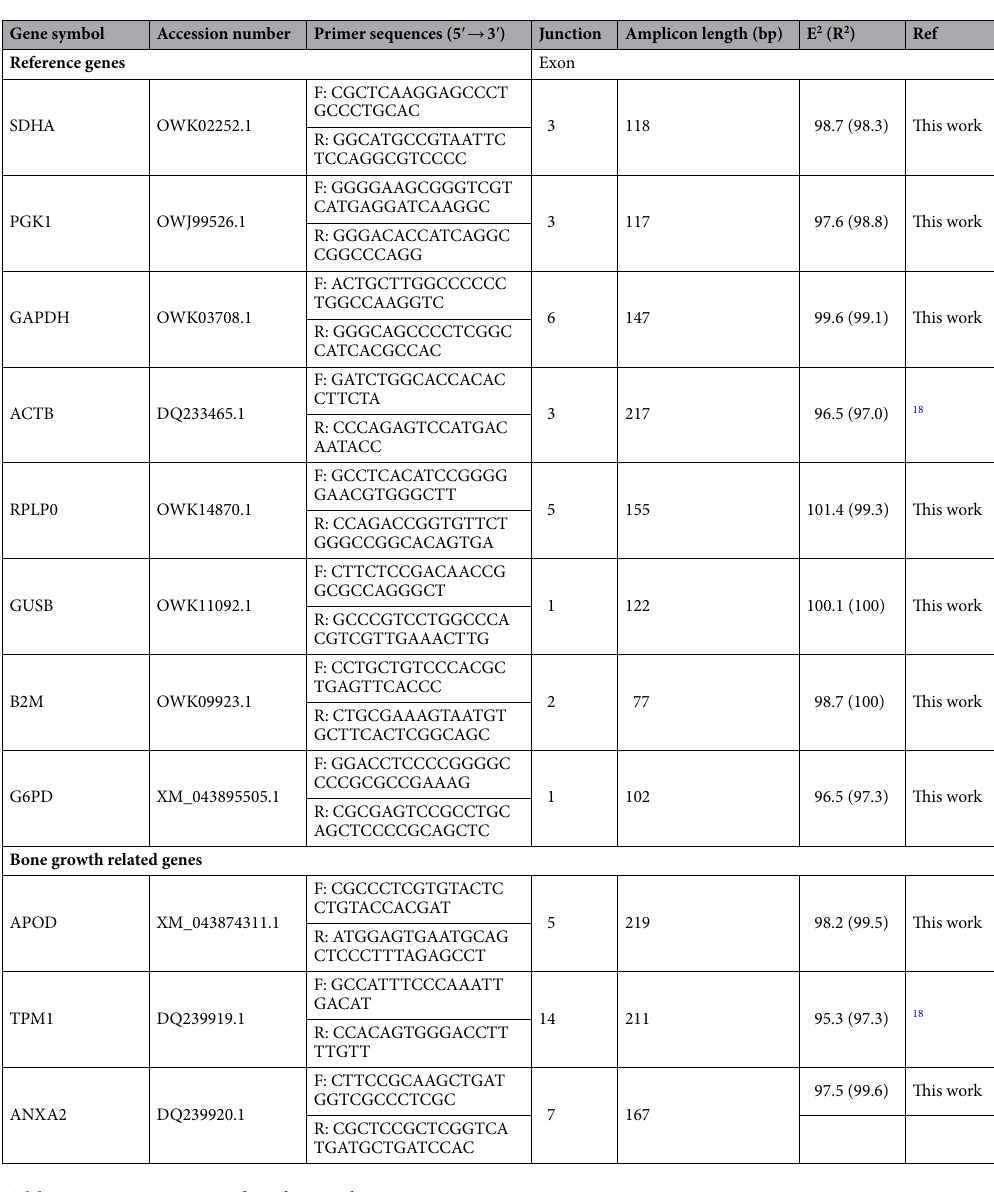
Table 1. Primer pairs used in this